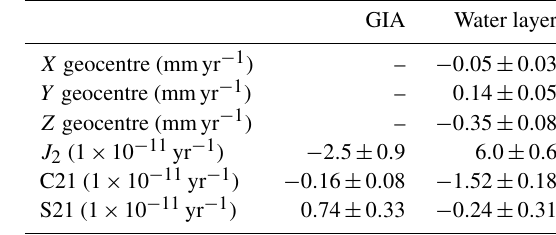
Table 2. Estimated linear trends (January 2003–August 2016) of geocentre motion, Earth’s dynamic oblateness ( J 2 ), and secular po- lar motion (C21, S21). Errors represent the 90% confidence level. C21 and S21 can be converted into units of ◦ Myr − 1 by multiplying them by a factor of − 6 . 9 × 10 10 (Chambers et al.,